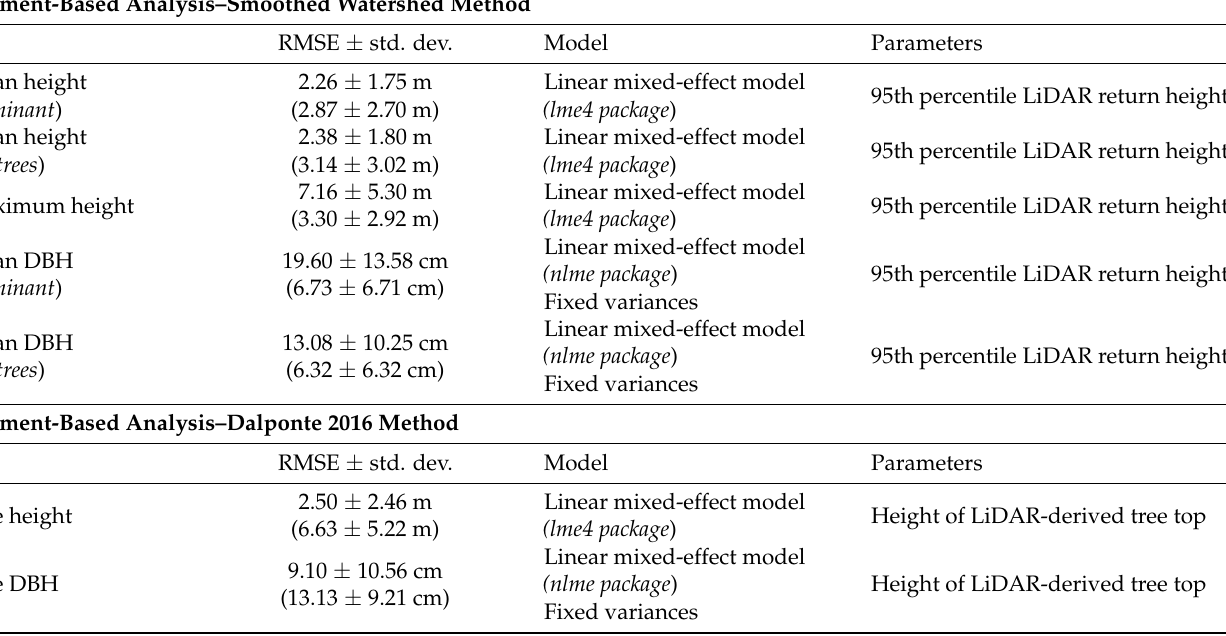
Table 6. Results of individual-tree-based models of forest structure. Ground-truth data were averaged within each segment for the watershed method, but the Dalponte2016 method was ground-truthed with one dominant tree per segment. watershed = 330 from 91 plots; nDalponte = 1030 from 97 plots. Accuracies of segment-based analysis, when restricted to segments with ground-truth data, are in parentheses; other values represent segmentation accuracy when scaled up to the same level as the area-based analysis (i.e., field-validated accuracy of model predictions when evaluated at the 30-m scale). Mixed models were calculated using R packages “nlme” and “lme4” [51,52].